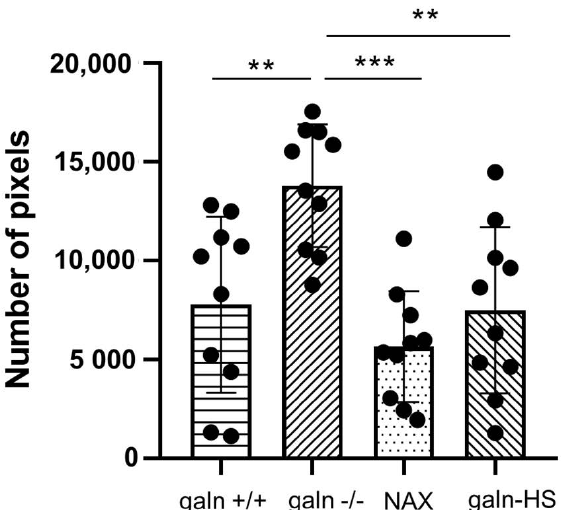
Figure 2. Cell degeneration after copper sulfate treatment. Number of fluorescent pixels after copper sulfate exposure in the wild-type galn +/+ group ( galn+/+ ), a line with galanin knockout galn − / − ( galn − / − ) and wild-type galn +/+ treated with galanin analog NAX 5055 (NAX) and a line with galanin overexpression Tg( hsp70l:galn ) (galn-HS). Data and mean ± SEM were pulled from three independent experiments. ** p < 0.01; *** p < 0.001 (determined using ANOVA with Tukey’s post hoc test).